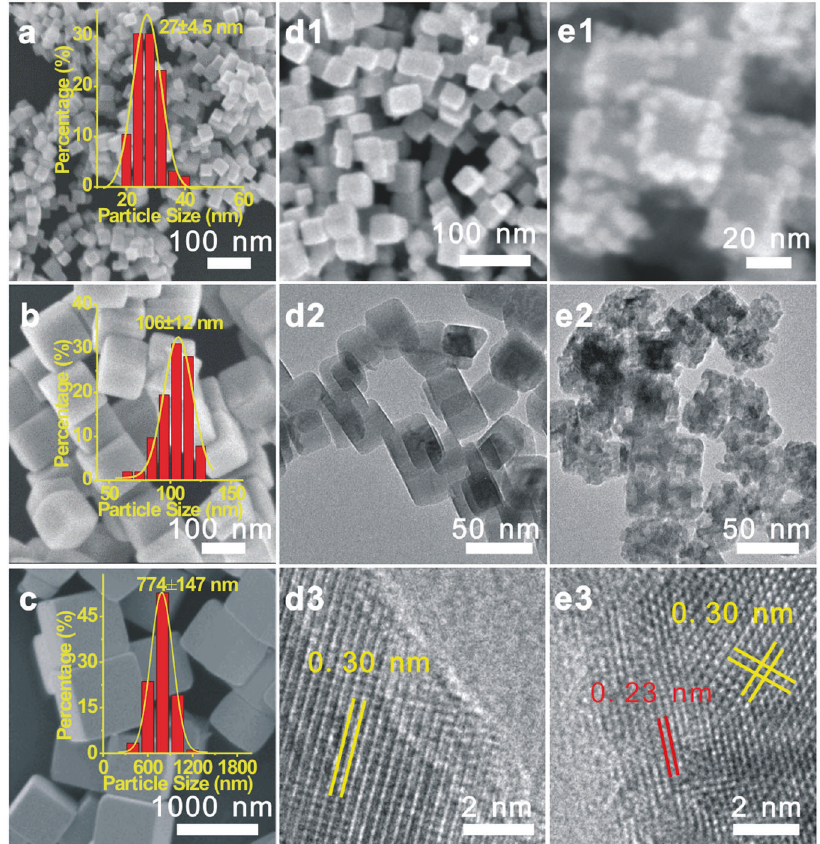
Fig. 1 Microscopic characterization of Cu 2 O NCs. SEM images and particle size distributions of a c-Cu 2 O-27, b c-Cu 2 O-106, and c c-Cu 2 O-774. SEM, TEM, and HRTEM images of c-Cu 2 O-27 after evaluated in C 3 H 6 oxidation with O 2 at 90 ( d1 – d3 ) and 150 °C ( e1 – e3 ). Lattice fringes of 0.30 and 0.23 nm correspond to the spacing of the Cu 2 O{110} (JCPDS card no. 78-2076) and CuO{111} (JCPDS card no. 89-5899) crystal planes, respectively.